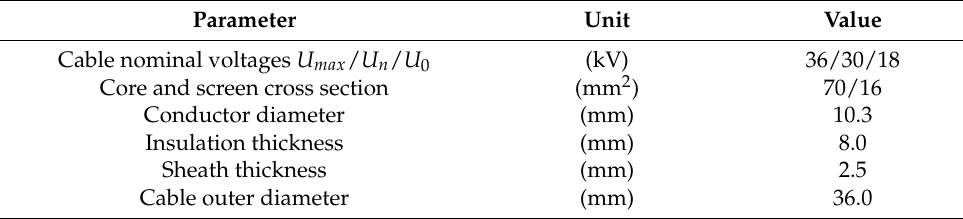
Table 1. Basic medium-voltage (MV) cable